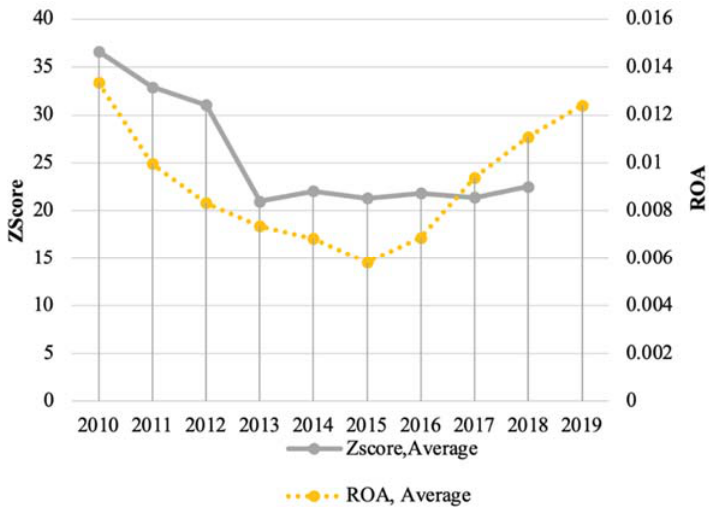
Figure 2. Z ‐ score and ROA in Vietnam.